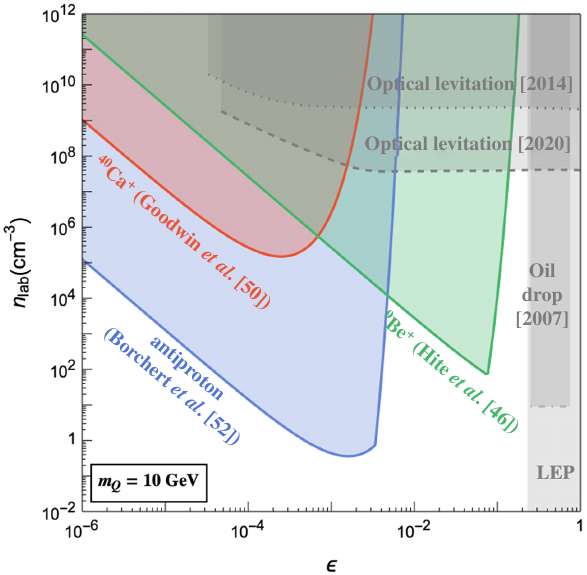
FIG. 3. A comparison of the (95% confidence limit) limits derived in this work from Refs. [46,50,52] with existing limits from oil-drop [36] and levitation [37,38] experiments and LEP [7] for m Q = 10 GeV.